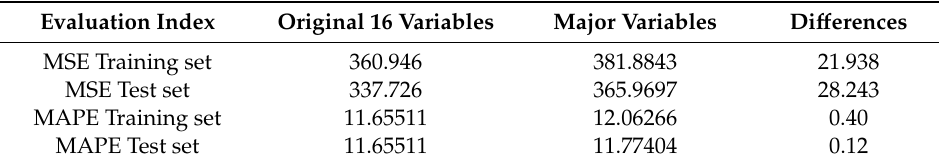
Table 7. Comparison of Mean Squared Error (MSE) and Mean Absolute Percentage Error (MAPE) associated with the regression analyses.